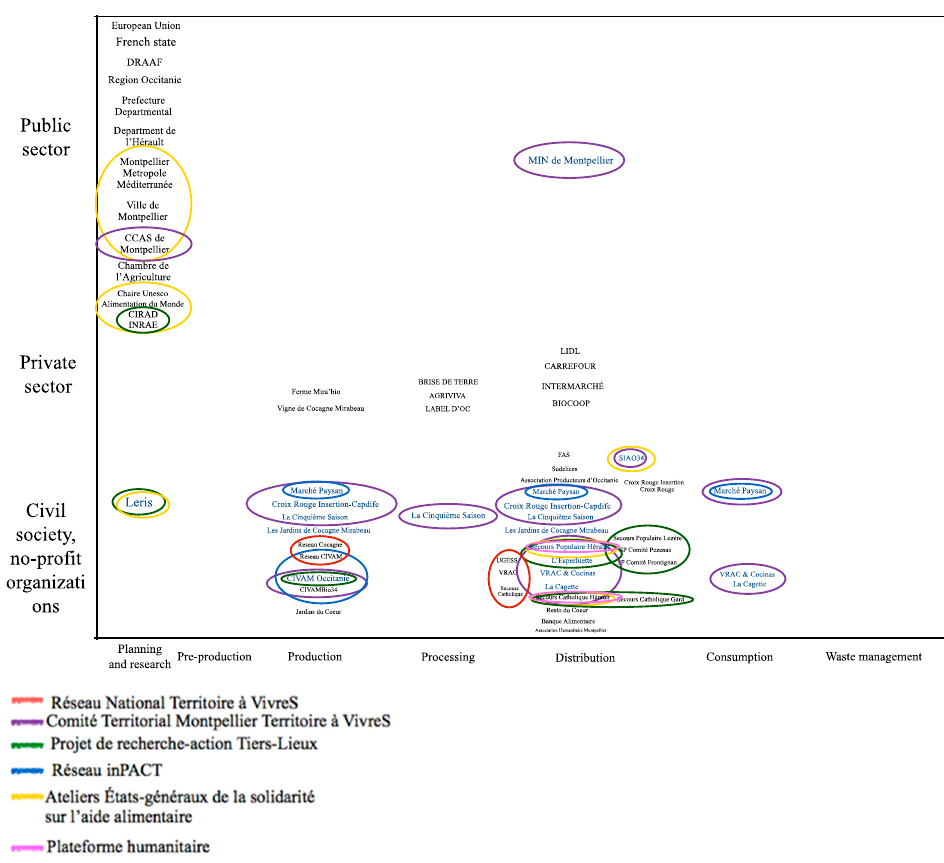
Figure 4. All the 54 actors identified.